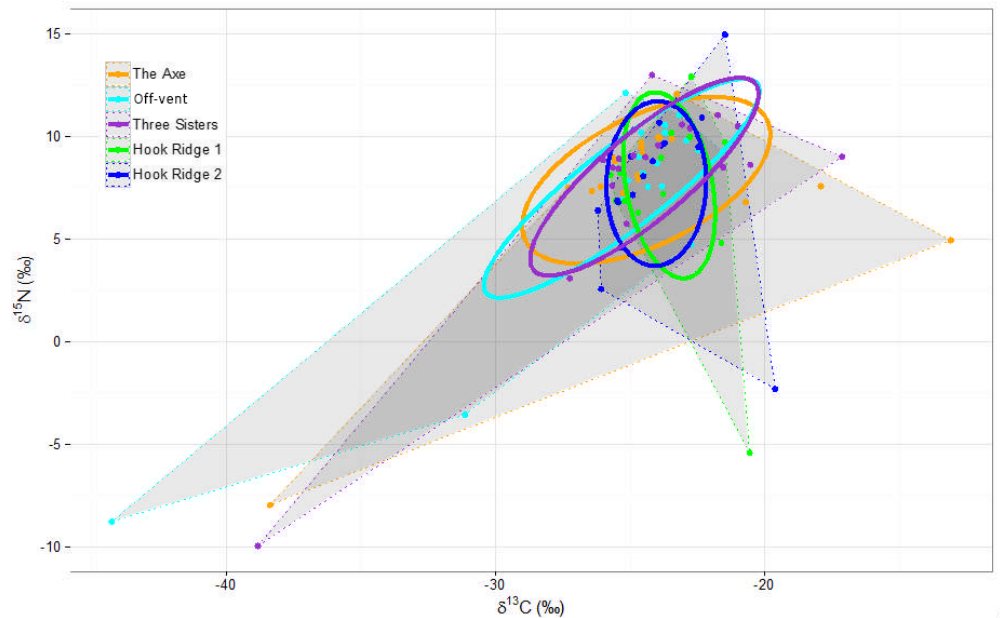
Figure 6. Faunal isotopic signatures (mean per species) grouped by site with total area (shaded area marked by dotted lines) and sample- size-corrected standard elliptical area (solid